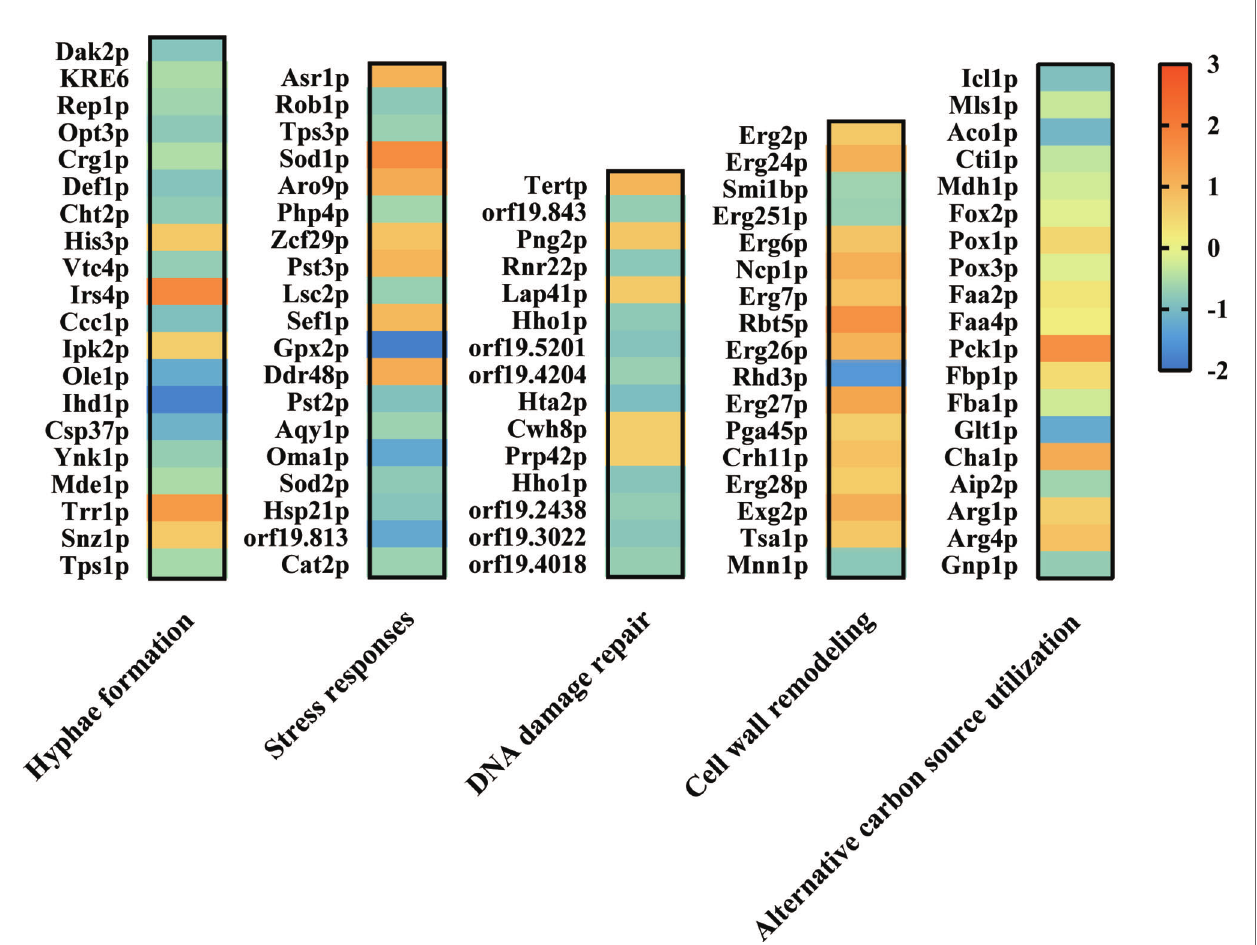
FIGURE 9 | Effect of ATP2 on proteins associated with C. albicans escape from macrophage. Summary of differentially expressed proteins related to hyphae formation, stress responses, DNA damage repair, cell wall remodeling, and alternative carbon source utilization in proteomic results. Compared to WT, the differentially expressed proteins in atp2 D / D mutant were identi fi ed at p < 0.05 and fold change > 1.5. The log 2 (FC) values were presented as a heat